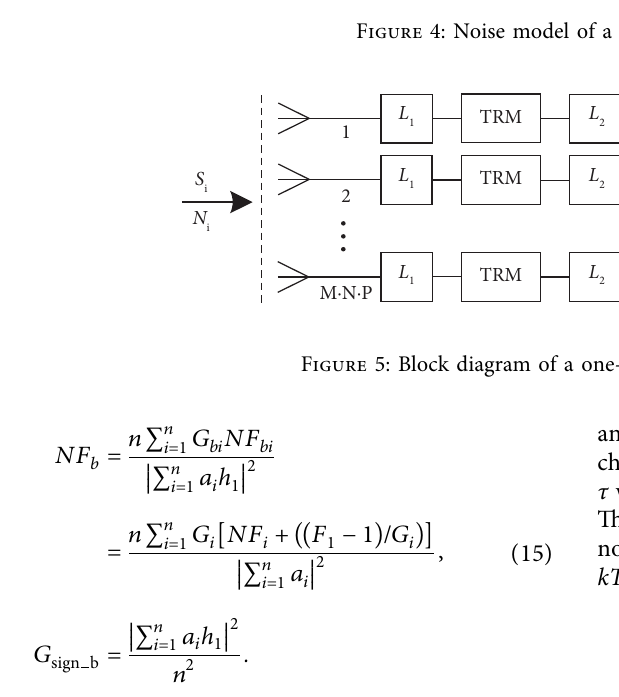
Figure 4: Noise model of a combiner network.